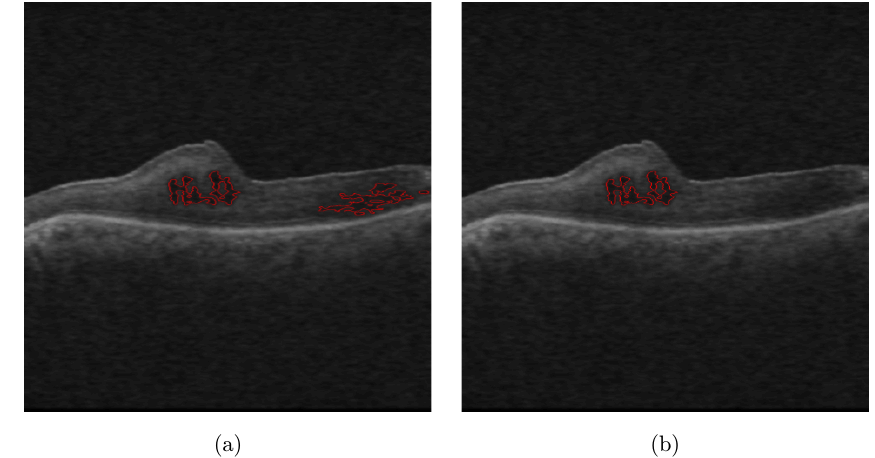
Fig. 6. (a) The result without thickness thresholding and (b) The image processed by thickness